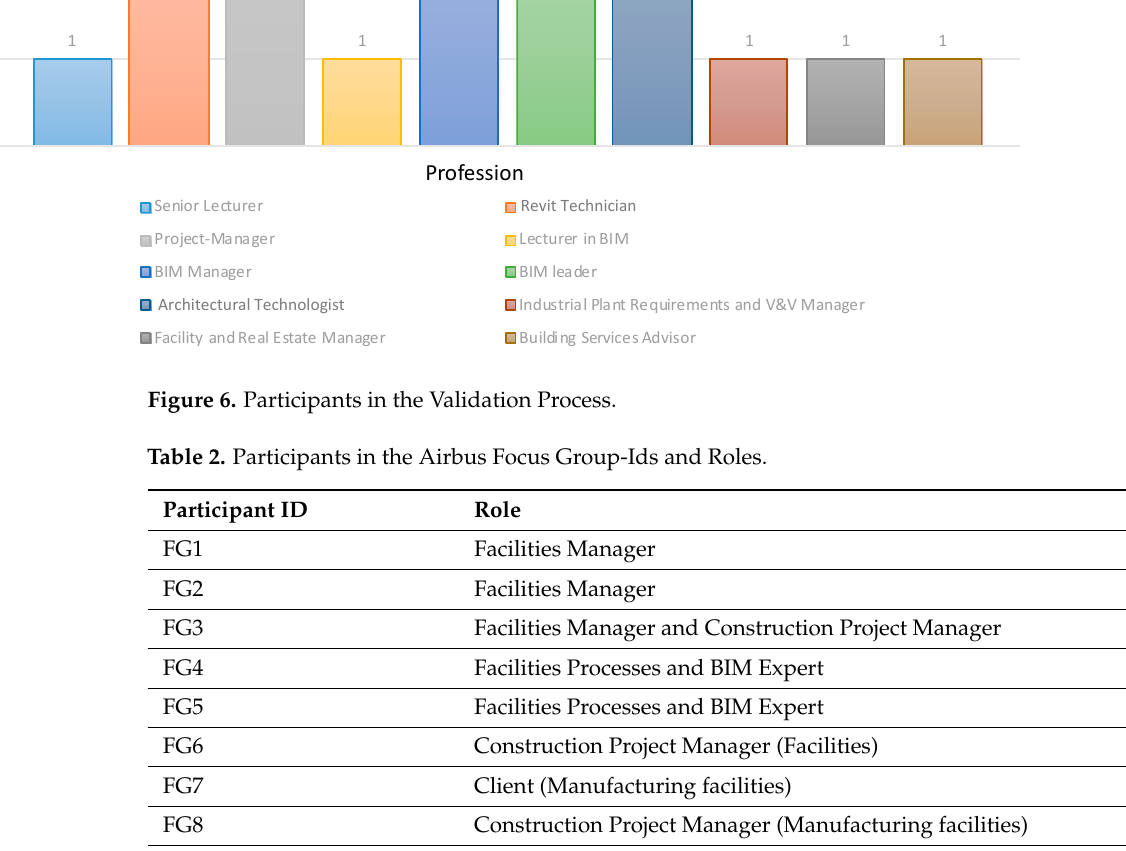
Table 2. Participants in the Airbus Focus Group-Ids and Roles.